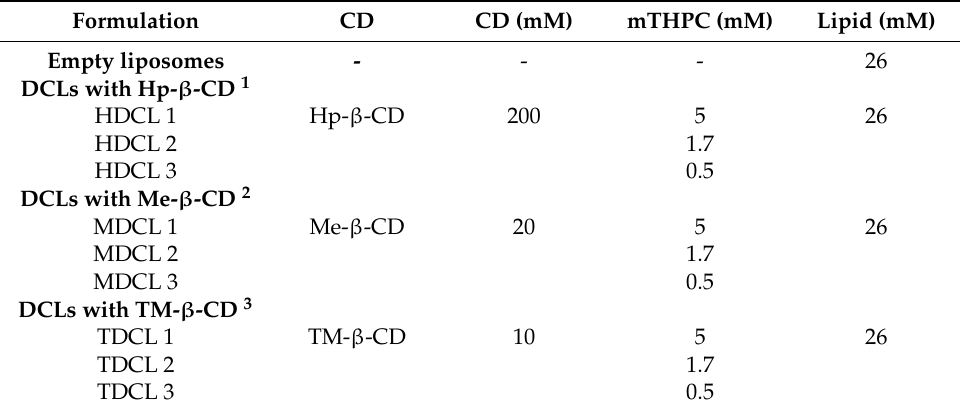
Table 1. Composition of the different mTHPC-DCL